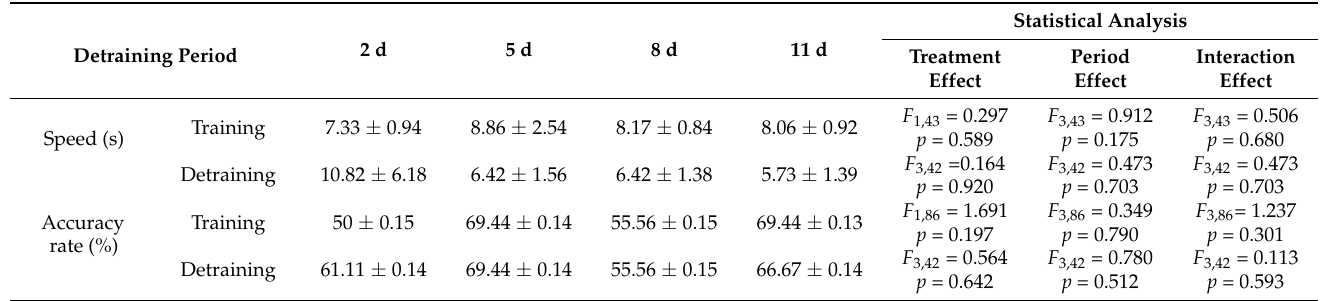
Table 1. Results of the memory retention test, i.e., comparison of speed and accuracy rate after 7 d of training with those for the same fish following a different period of detraining based on a linear mixed-model analysis (parameter data are presented as means S.E.).